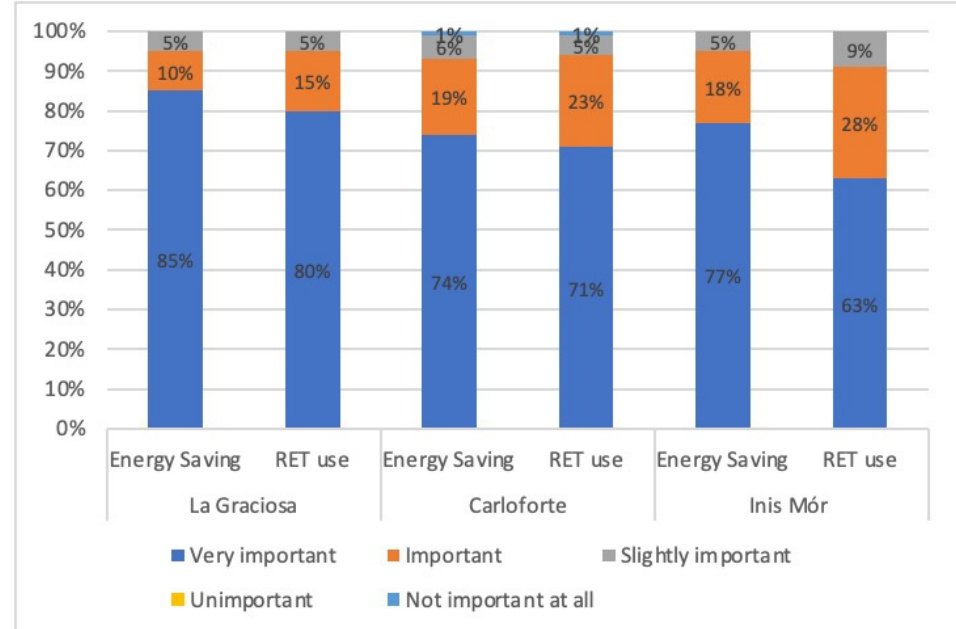
Figure 2. Importance of energy saving and RET use for households in the three islands.